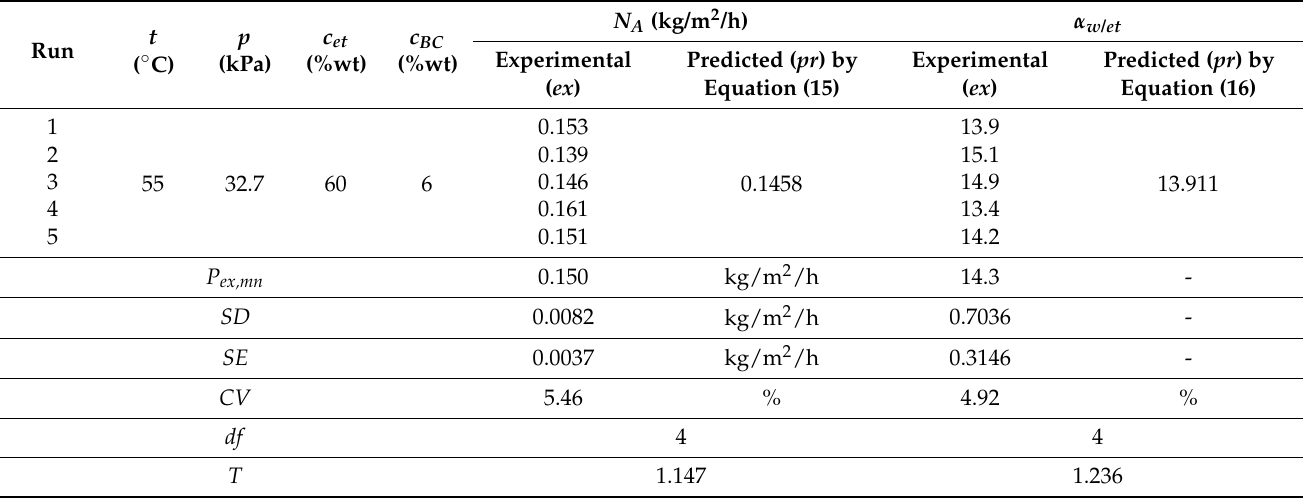
Table 5. ExperimentalandcalculateddataforreplicatesusedtovalidatethestatisticalmodelsdescribedbyEquations (15) and (16).